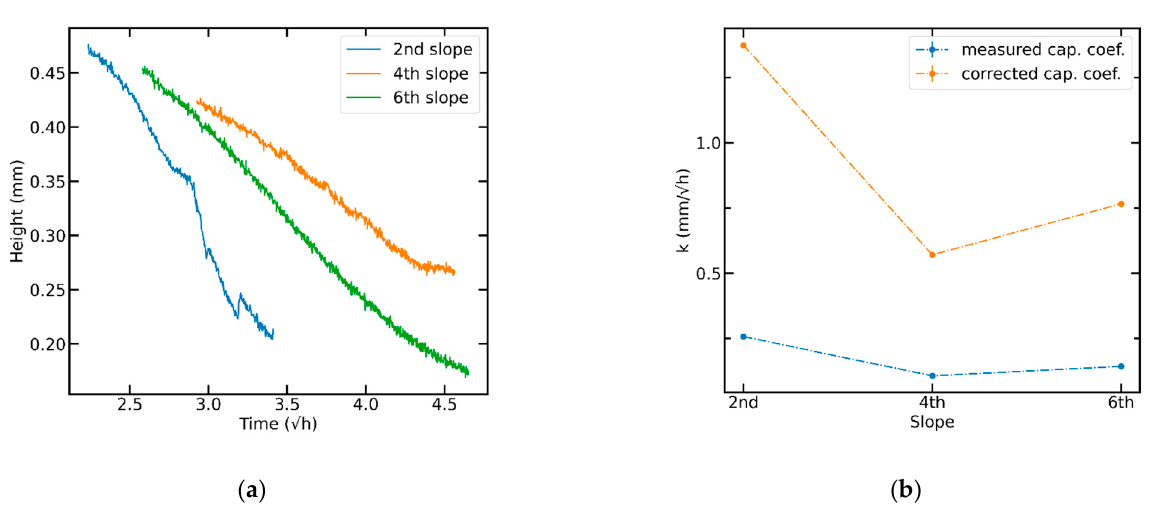
Figure 8. ( a ) Comparison of the different slopes of the “wet” cycles of sample B plotted as the height of water over the square root of time. ( b ) The respective capillary coefficients obtained from the “wet” cycle’s slopes and the respective corrected values.